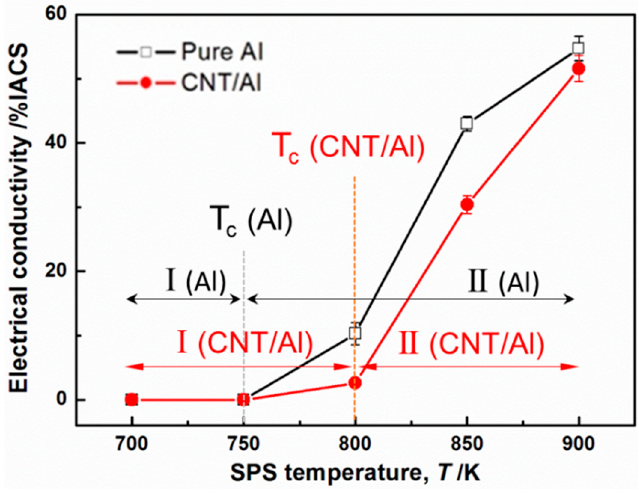
Figure 3. Electrical conductivity of pure Al and CNT–Al composites sintered under different temperatures.